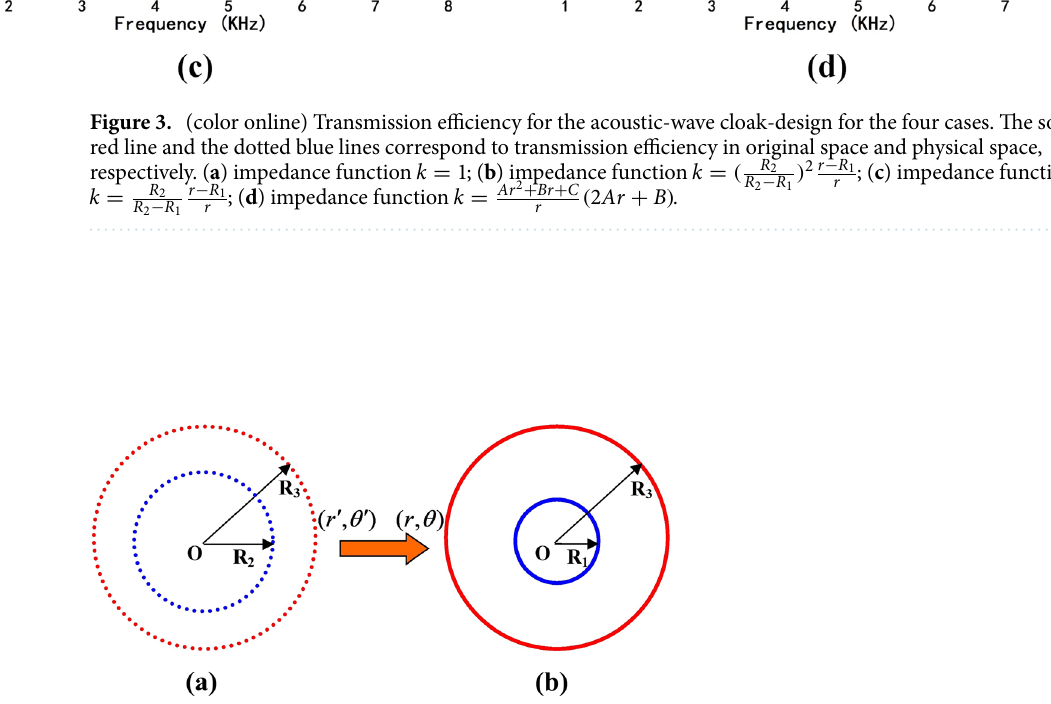
Figure 4. (color online) Coordinate transformation of an acoustic concentrator. ( a ) original space, ( b ) transformed